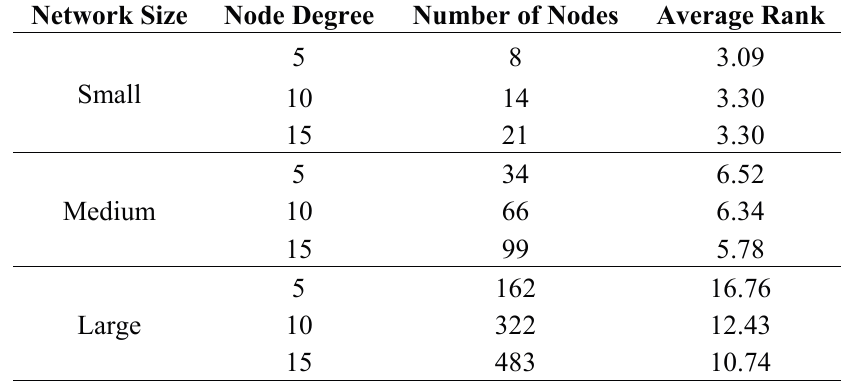
Table 2. Number of nodes and average rank for each network size scenario and